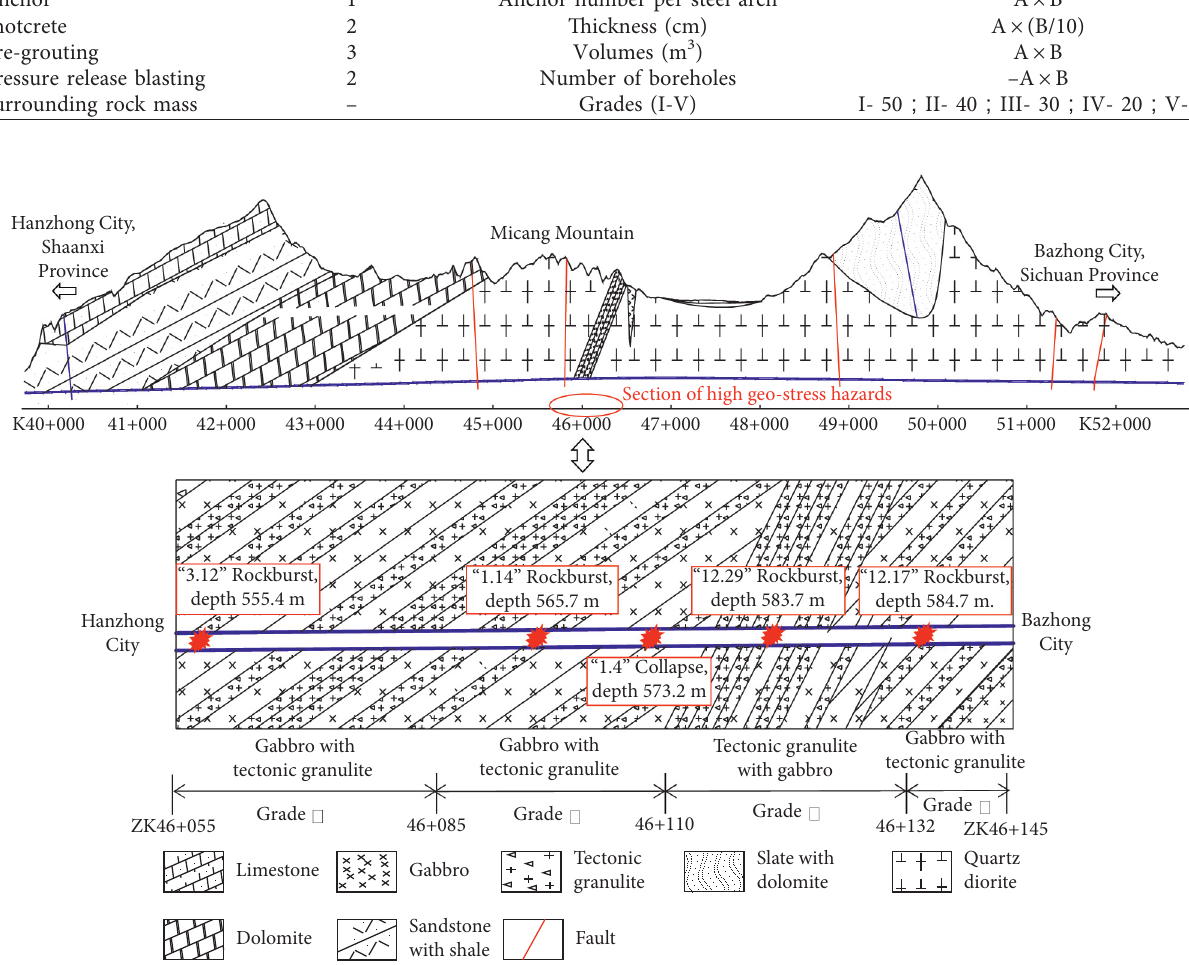
Figure 1: The geological cross-section along the Micangshan tunnel, China